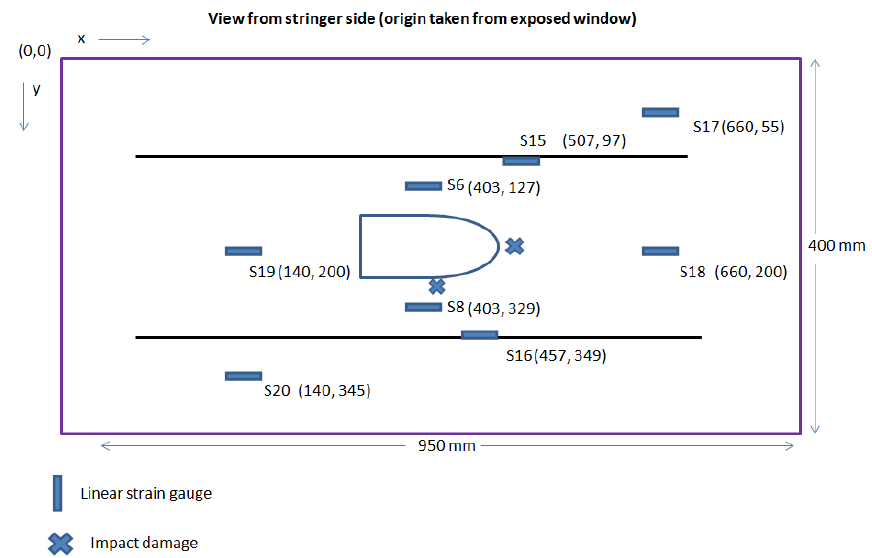
Figure 17. Strain gauge locations on the panel (stringer side). Next, the panel was subjected to quasi-static tensile loading using a servohydraulic actuator (Figure 18). The load was simultaneously measured by a load cell and strain gauge readings, and DIC images were recorded for post processing.